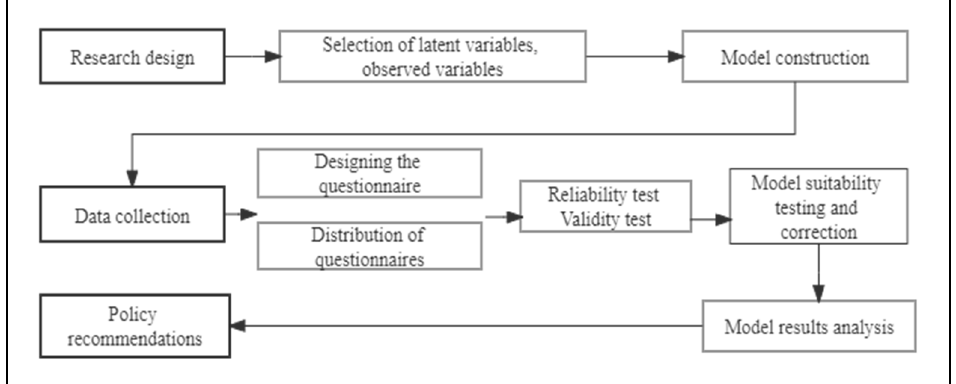
Figure 2. Research